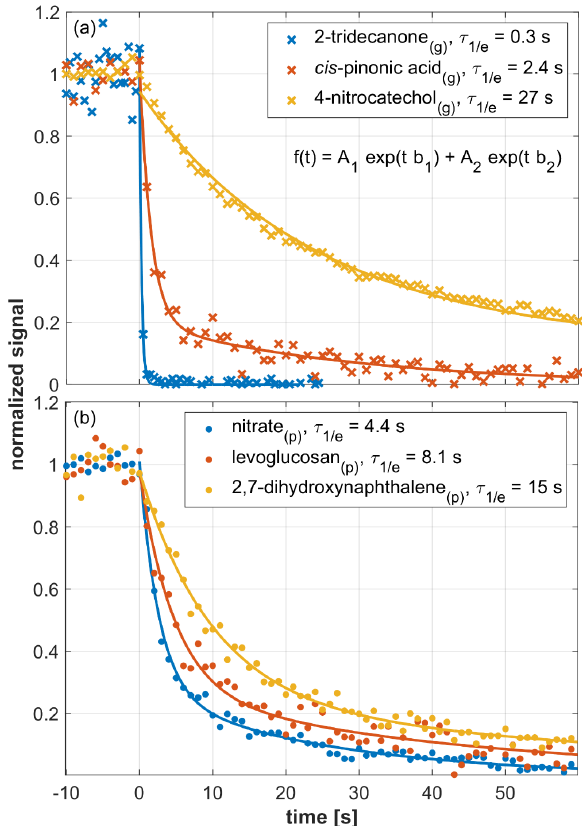
Figure 3. Signal decay as observed in an EVR PTR-MS an- alyzer ( T drift = 120 ◦ C) after a steady supply of analyte was instantly switched off at t = 0s. The decay of gaseous an- alytes is shown in the upper panel, while the lower panel refers to particulate analytes. Initial steady-state mixing ra- tios were as follows: 2-tridecanone ( g ) , 1ppbv; cis -pinonic acid ( g ) , 2.2ppbv; 4-nitrocatechol ( g ) , 30ppbv; nitrate, 3ppbv; levoglucosan ( p ) , 1.2ppbv; 2,7-dihydroxynaphthalene ( p ) , 0.3ppbv. Signals were fitted using a double exponential decay function (see insert in a ). All fitting parameters are listed in Table